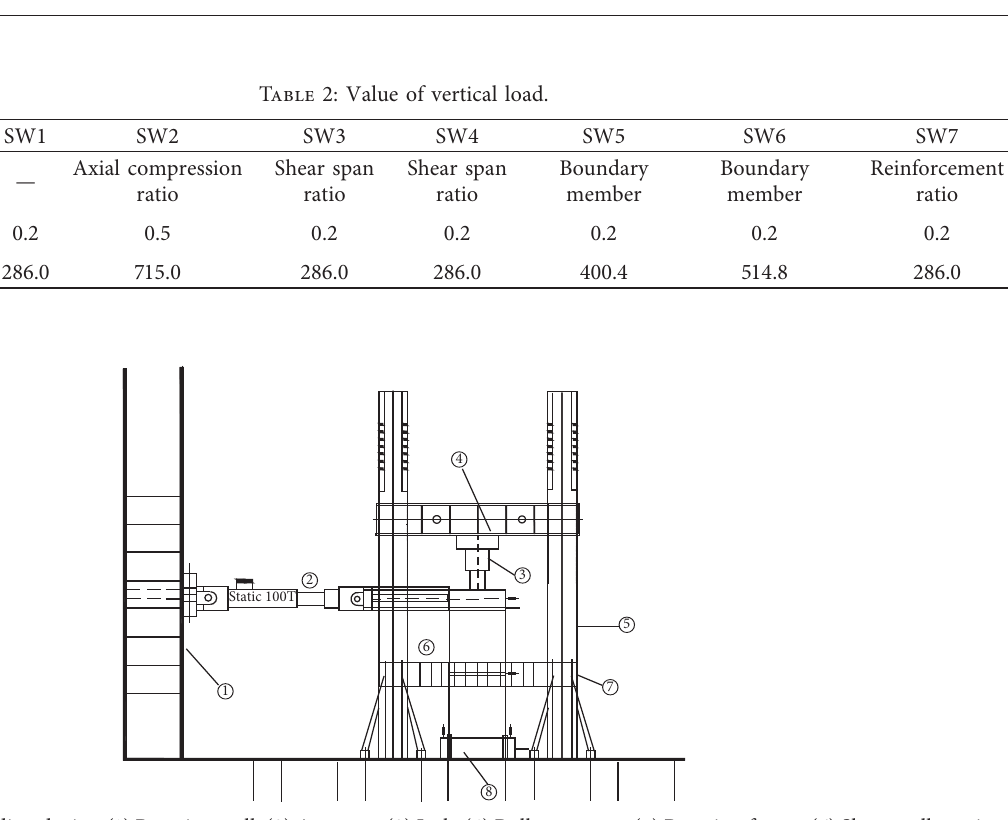
Figure 2: Shear wall loading device. (1) Reaction wall. (2) Actuator. (3) Jack. (4) Roller support. (5) Reaction frame. (6) Shear wall specimen. (7) Lateral confined steel beam. (8)